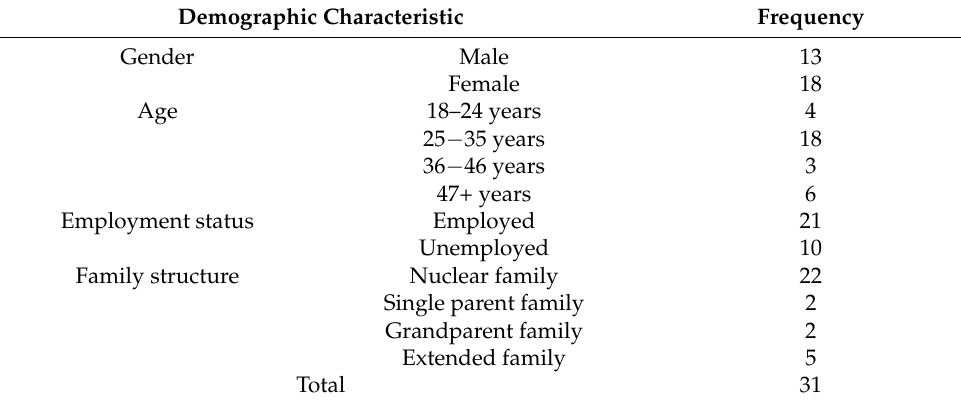
Table 1. Demographic characteristics of the